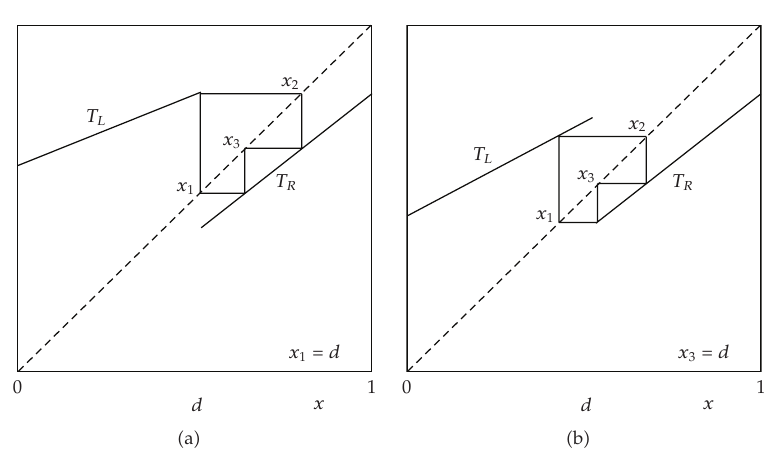
Figure 11: (cid:2) a (cid:3) Starting condition for a cycle of period 3 (cid:2) b (cid:3) closing condition for the same cycle, both related to border-collision boundaries of the corresponding periodicity tongue in the space of